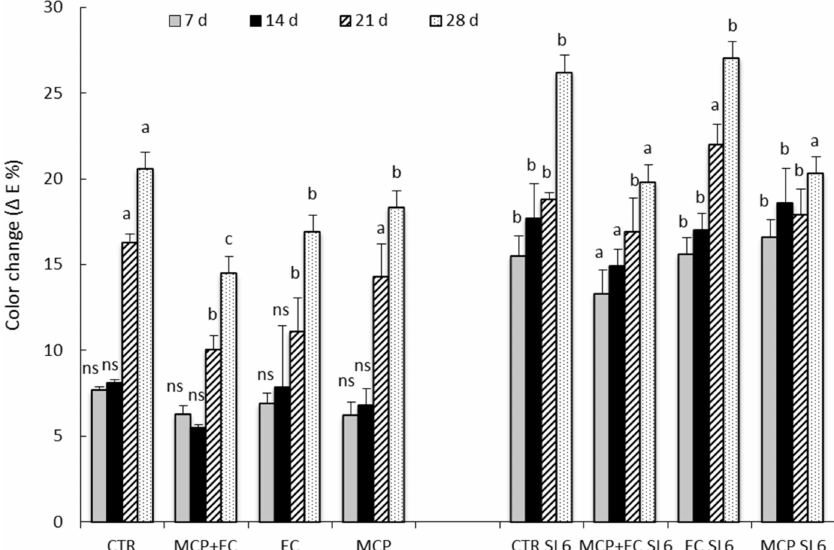
Figure 6. Color change ( ∆ E %) of “peach” fruit, cv. “ Settembrina ” coated with an edible coating made of Aloe arborescens pure mucilage (EC), 1-MCP + coating, treated (CTR), and stored for 7, 14, 21 and 28 days at 1 ◦ C + color change during shelf life after 6 days at 20 ◦ C (SL6). Data correspond to the means ± standard error bars (SE) of 15 replicates. Means with di ff erent letters are significantly di ff erent at p ≤ 0.05 using Tukey’s test. ns = not significant. Di ff erent lowercase letters denote significant di ff erences ( p ≤ 0.05) among di ff erent treatments for the same sampling time. SL6 = cold storage days (0, 7, 14, 21, 28) at 1 ◦ C, followed by shelf life for 6 days at 20 ◦